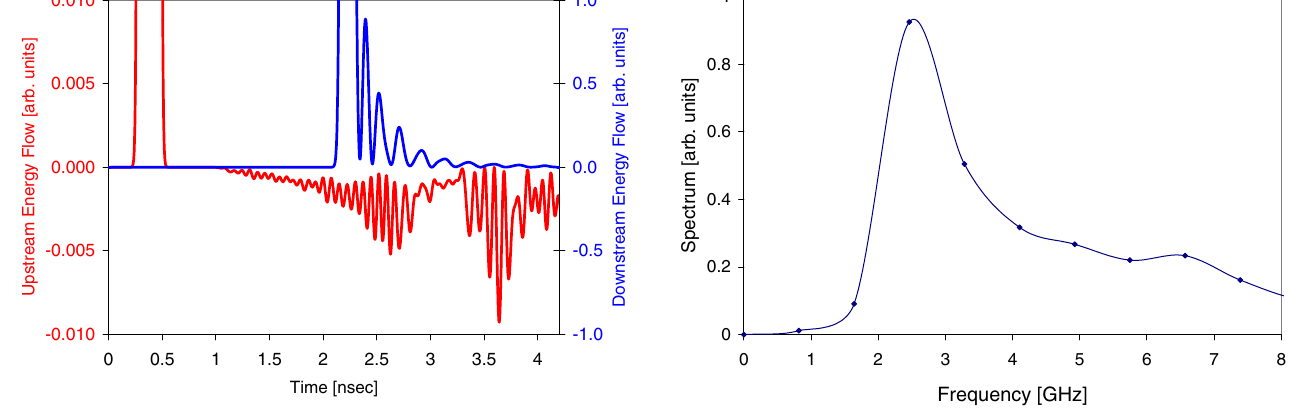
FIG. 7. (Color) Calculated spectrum of the collimator wakefield of a single